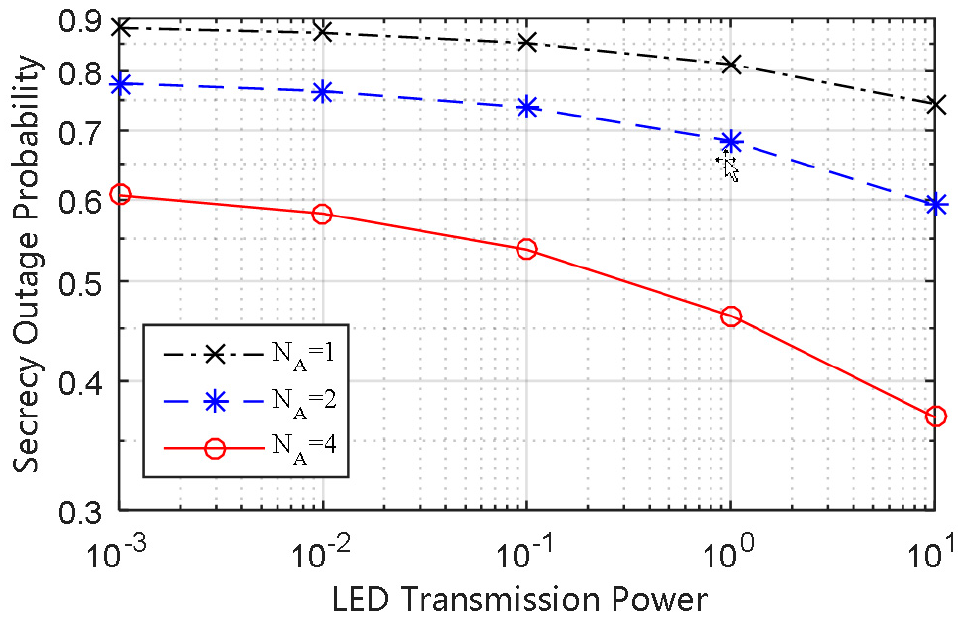
Figure 3. Secrecy outage probability (SOP) of the strong user versus the number of light-emitting diodes